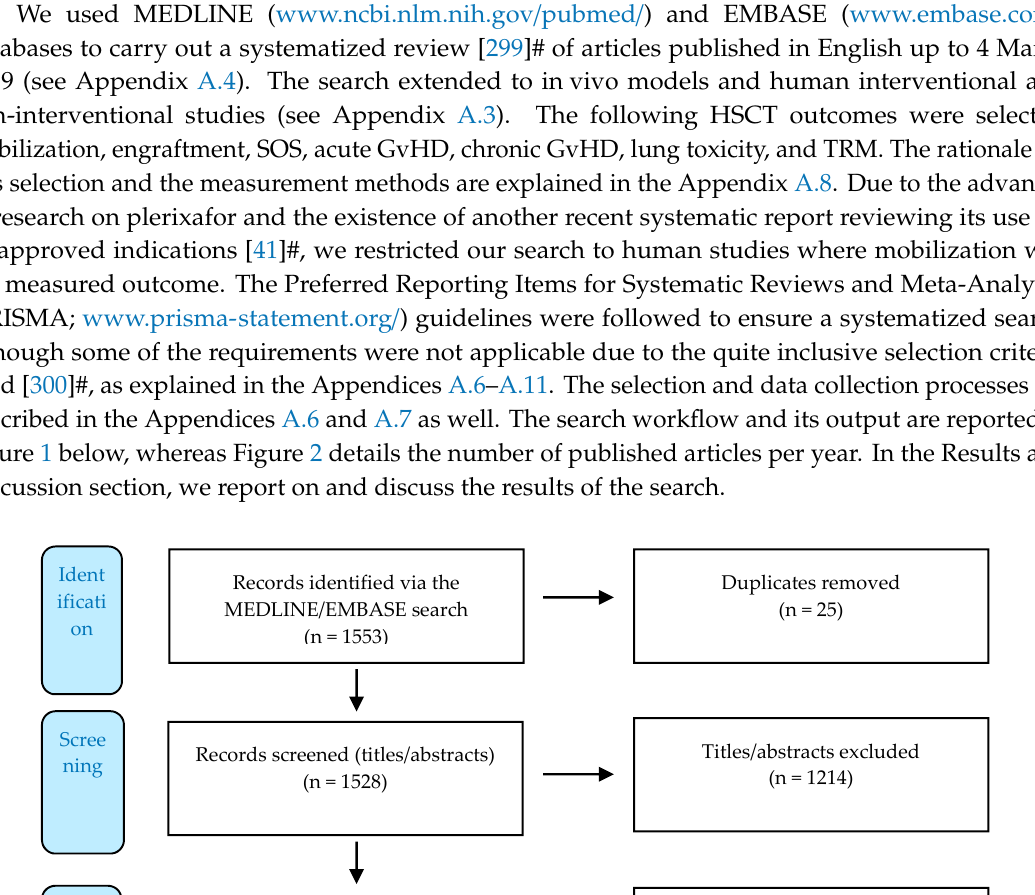
05101520253035 199920002001200220032004200520062007200820092010201120122013201420152016201720182019 Figure 2. Number of animal (orange) or human (blue) studies per year reporting any association between at least one G protein-coupled receptor (GPCR) and at least one of the selected hematopoietic stem cell transplantation (HSCT) outcomes: mobilization, engraftment, treatment-related toxicities (TRTs) [veno-occlusive disease (VOD), acute graft-versus-host disease (aGvHD), chronic graft-versus- host disease (cGvHD), lung toxicity], and transplantation- or treatment-related mortality (TRM). N = 223. These records were selected via two rounds of systematized screening for eligibility/exclusion criteria (see the Appendix A6 ). §: up to 4 March 2019. 4. Conclusions and Perspectives